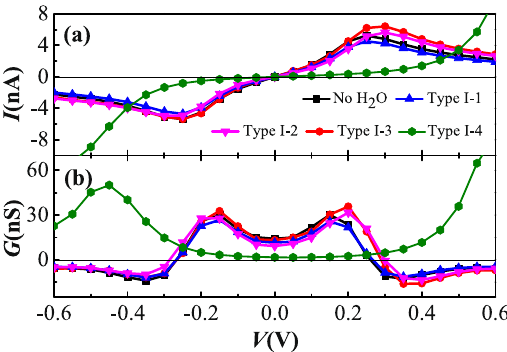
Figure 2. Electronic transport properties of TADHA molecular junction without or with one H 2 O molecule adsorbate, ( a ) Current and ( b ) Differential conductance as functions of applied bias